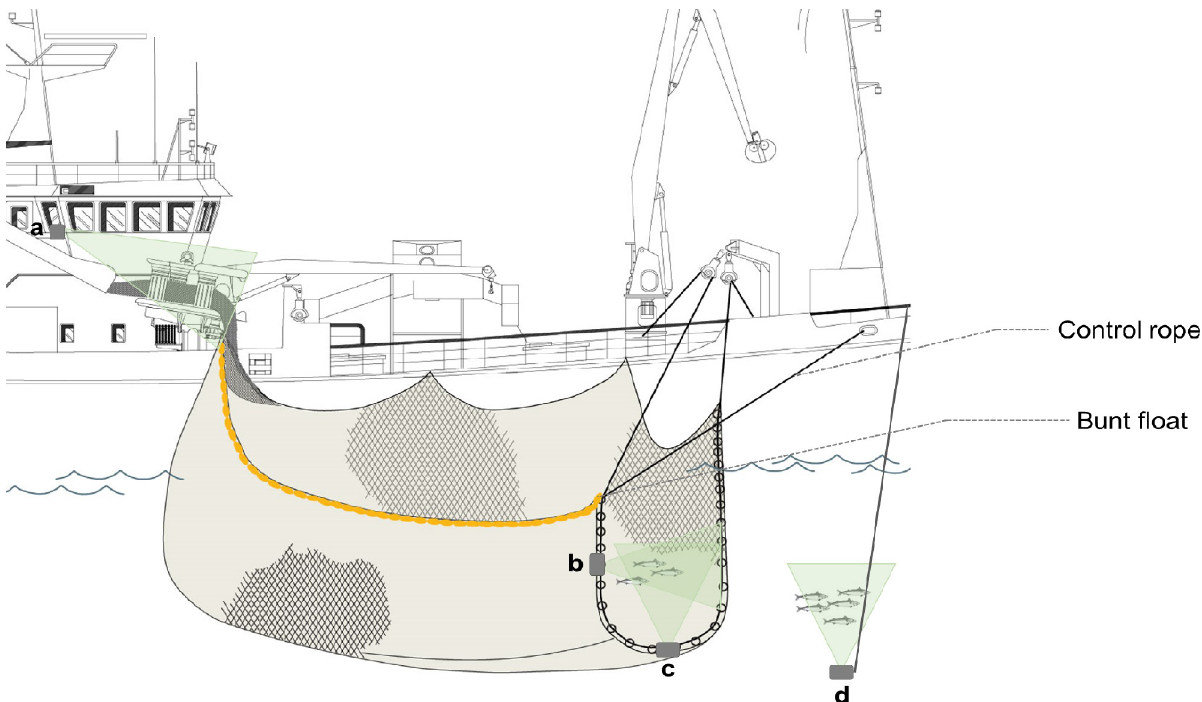
Fig 2. Illustration of the discharge opening and camera positioning. The discharge opening was formed in the bunt end of the purse seine to allow fish escape. The positioning of cameras (and approximate filming orientation in green) for observation of behaviour is indicated: a) bridge camera to observe net hauling and discharge opening from the surface; b) horizontally orientated discharge camera; c) vertically orientated discharge camera and d) vertically orientated drop camera. See main text for further description of camera set up and slipping methodology. Adapted from [7], with permission